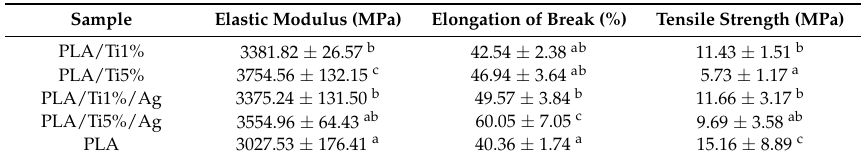
Table 1. The mechanical properties of pure PLA and PLA nano-blend films. Sample